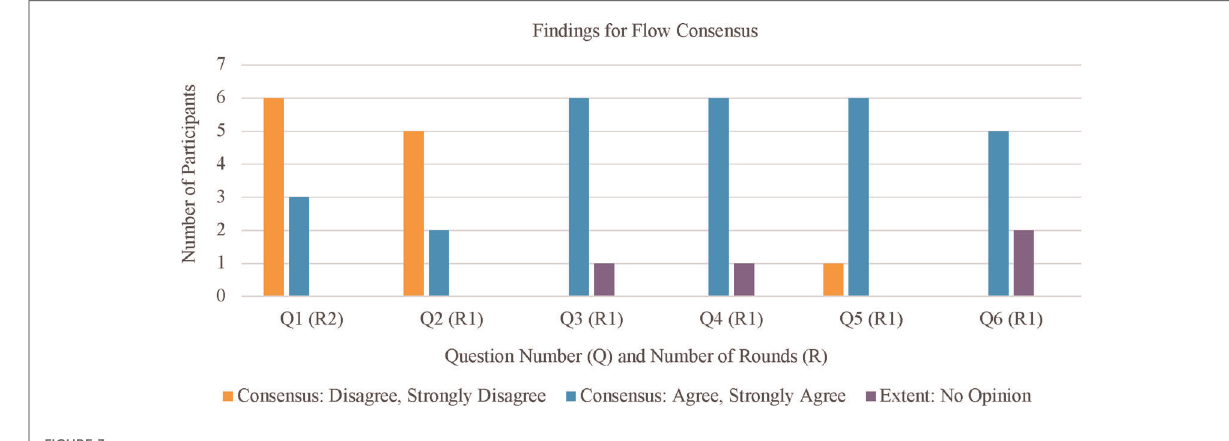
FIGURE 3 Accumulated results of the fl ow